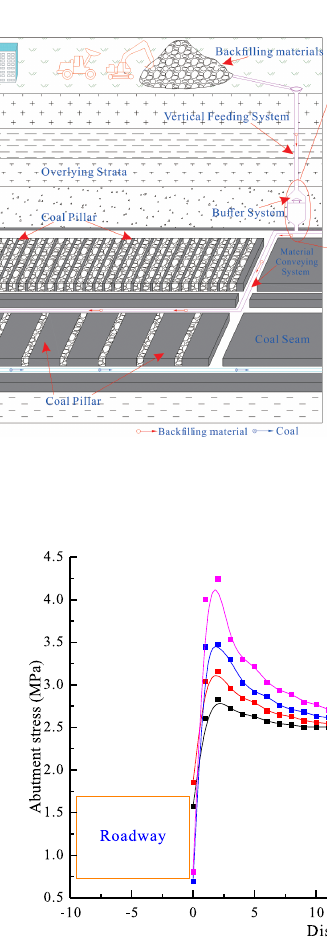
Figure 8. Distribution of abutment stresses on the